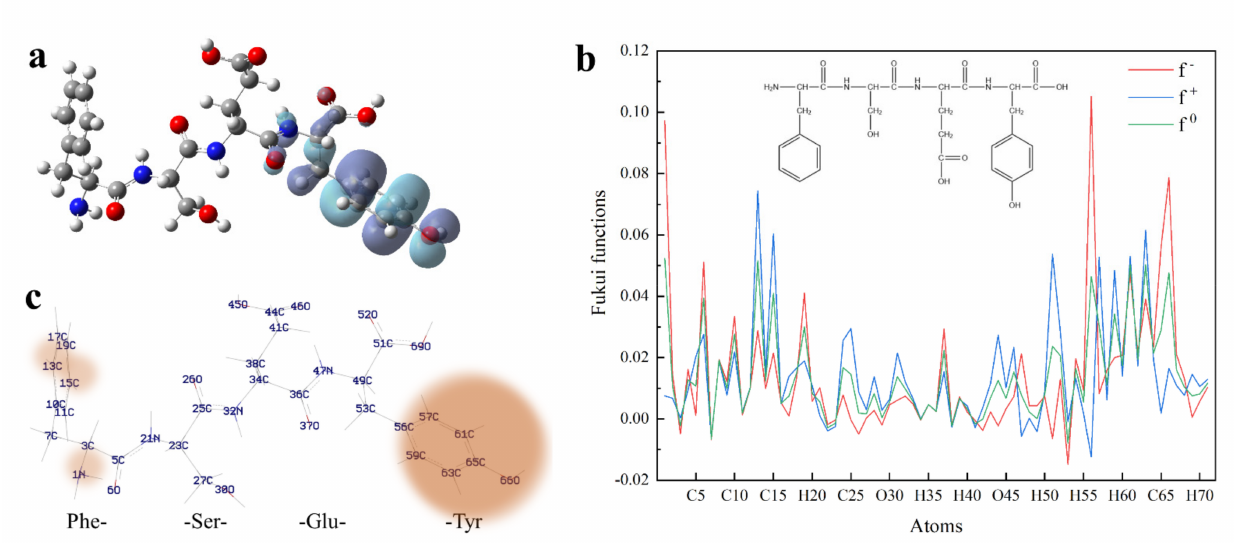
Figure 3. Quantum chemical parameters of FSEY. ( a ) shows HOMO distribution of peptide FSEY; ( b ) stands for Fukui functions; ( c ) means the predicting sites of FSEY more prone to a nucleophilic, electrophilic or radical attack. Note: red ball represents the oxygen atom; blue ball represents the ni- trogen atom; dark gray ball represents the carbon atom; light gray ball represents the hydrogen